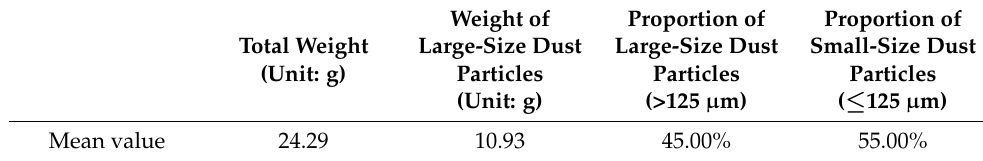
Table 2. Mean weights of the sieved dust particles.